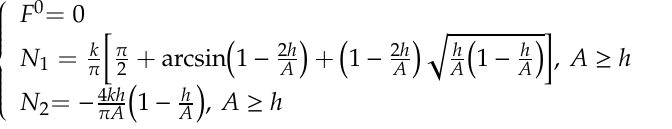
Figure 2. Reheat steam turbine model considering Generation Rate Constrains (GRC).